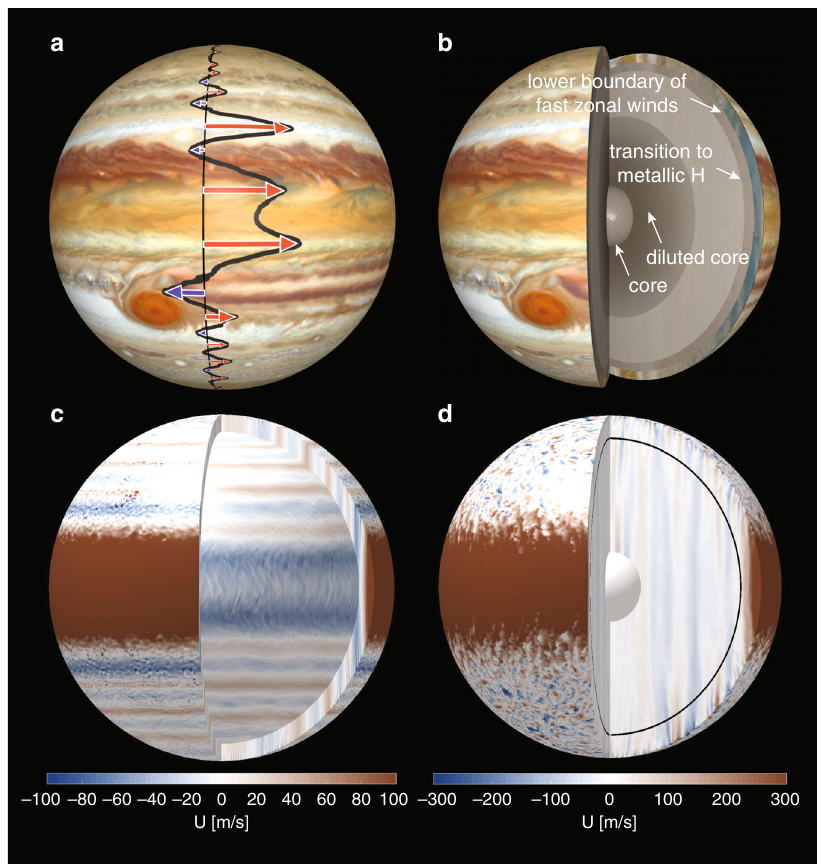
Fig. 1 The zonal winds and interior structure of Jupiter. a Jupiter ’ s cloud level zonal jets projected onto a Hubble surface image. The black line shows the jet velocity pro fi le while red arrows indicate eastward and blue arrows westward jet maxima. The fastest jets are eastward and reach a maximum velocity of about 130 m/s. b Interior model with an outer region of fast zonal jets (5% in radius), the transition to the metallic hydrogen region (10% in radius), a core (20% in radius), and a possible region of denser material that may consist of diluted core material 18 . c Color contours of the azimuthal fl ow U in a snapshot of a simulation in a shell covering 10% in radius 6 . Red and blue colors indicate eastward and westward winds respectively. d Color contours of the azimuthal fl ow U in a snapshot of a Jupiter-like dynamo simulation 10 . The black circle separates the weakly conducting outer and highly conducting inner region. Lorentz forces con fi ne the dominant prograde equatorial jet to the outer region and brake the other jets. On time average, only the equatorial jet persists. The other azimuthal fl ows are more time dependent and merge to form a broad slow westward fl ow. The image of Jupiter ’ s surface in panels ( a ) and ( b ) is courtesy to NASA and ESA. Credits go to A. Simon (Goddard Space Flight Center) and M.H. Wong (University of California, Berkeley). The simulations illustrated in panels ( c ) and ( d ) have been performed with the dimensionless computer code MagIC. The code calculates the azimuthal fl ows in units of a Rossby number: Ro = U/( r J Ω ). This has been rescaled to m/s by assuming a mean radius of r J = 6.9911 × 10 6 m and a planetary rotation rate of Ω = 1.759 × 10 − 4 s − 1